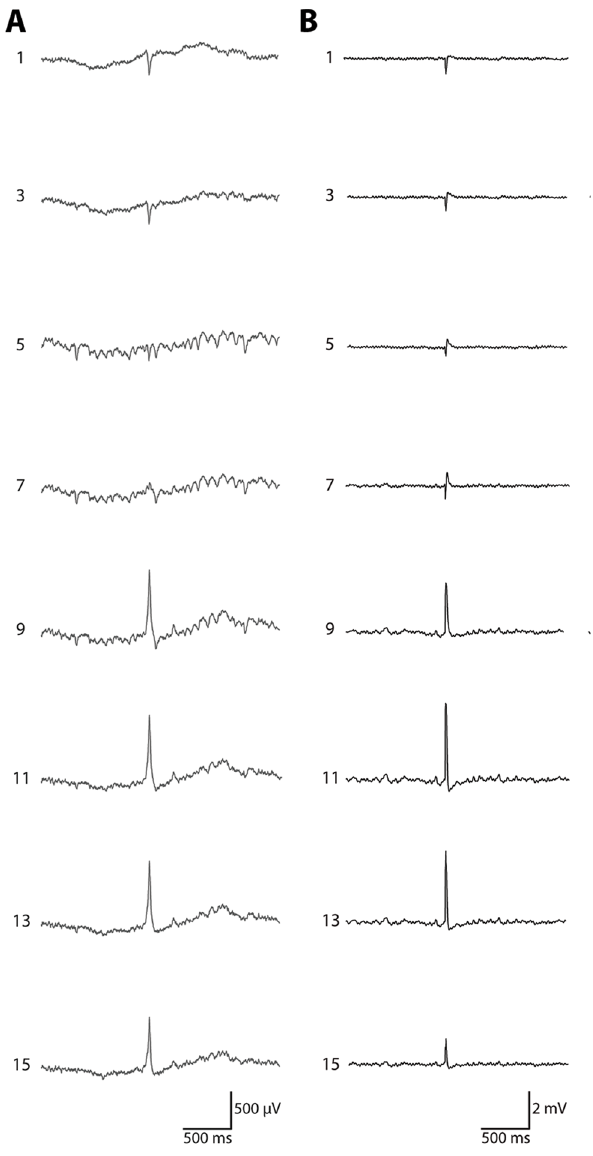
Fig 1. Simultaneous recoding of field activity in the CA1-dentate gyrus axis of dorsal hippocampus. For simplicity, every other trace is shown (16 total recording sites, 100 μ m contact intervals). A) A typical dentate spike was depicted in the traces shown, characterized by a large amplitude, highly contoured event with a positive going waveform in the dentate gyrus. The CA1 pyramidal cell layer was located near trace 3 and the dentate granule cell layer was located near trace 9. B) An example recording depicting a characteristic response to a angular bundle stimulation. The silicon probe was located in a similar orientation to the recording shown in panel A. The CA1 pyramidal cell layer was located near trace 3 and the dentate granule cell layer was located between traces 9 and 11.